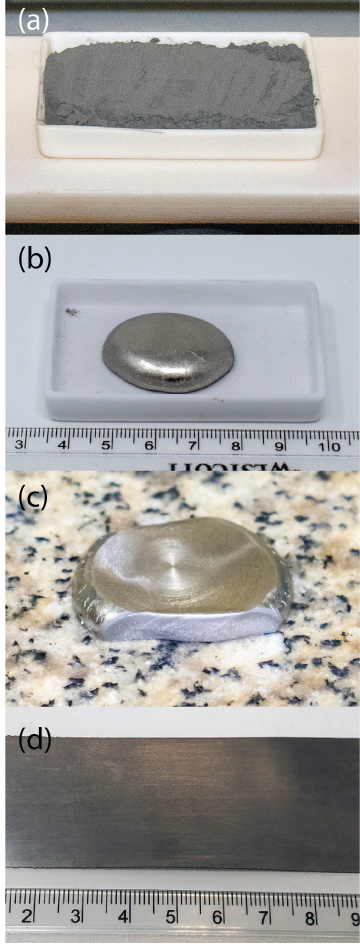
Figure 1. Permalloy was manufactured starting from high-purity source powders that are mixed (a) and then melted together (b) via 1h at 1550 ◦ C. The resulting ingot is flattened in a hydraulic press (c) , machined rectangular, and successively cold rolled into 100 and then 50µm foil (d)